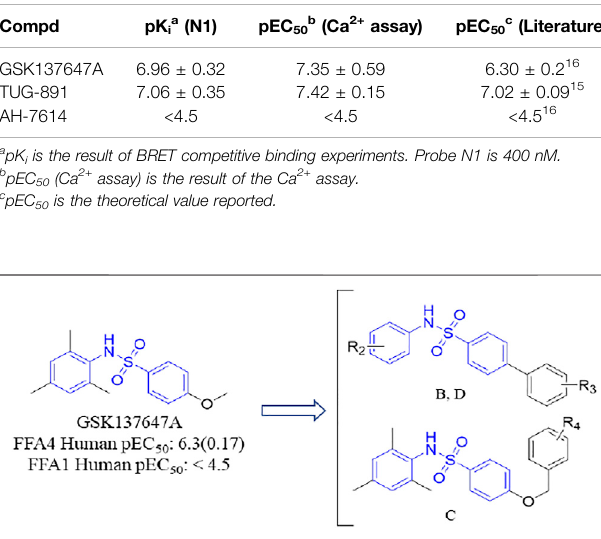
TABLE 2 | Comparison of BRET results to reference data.